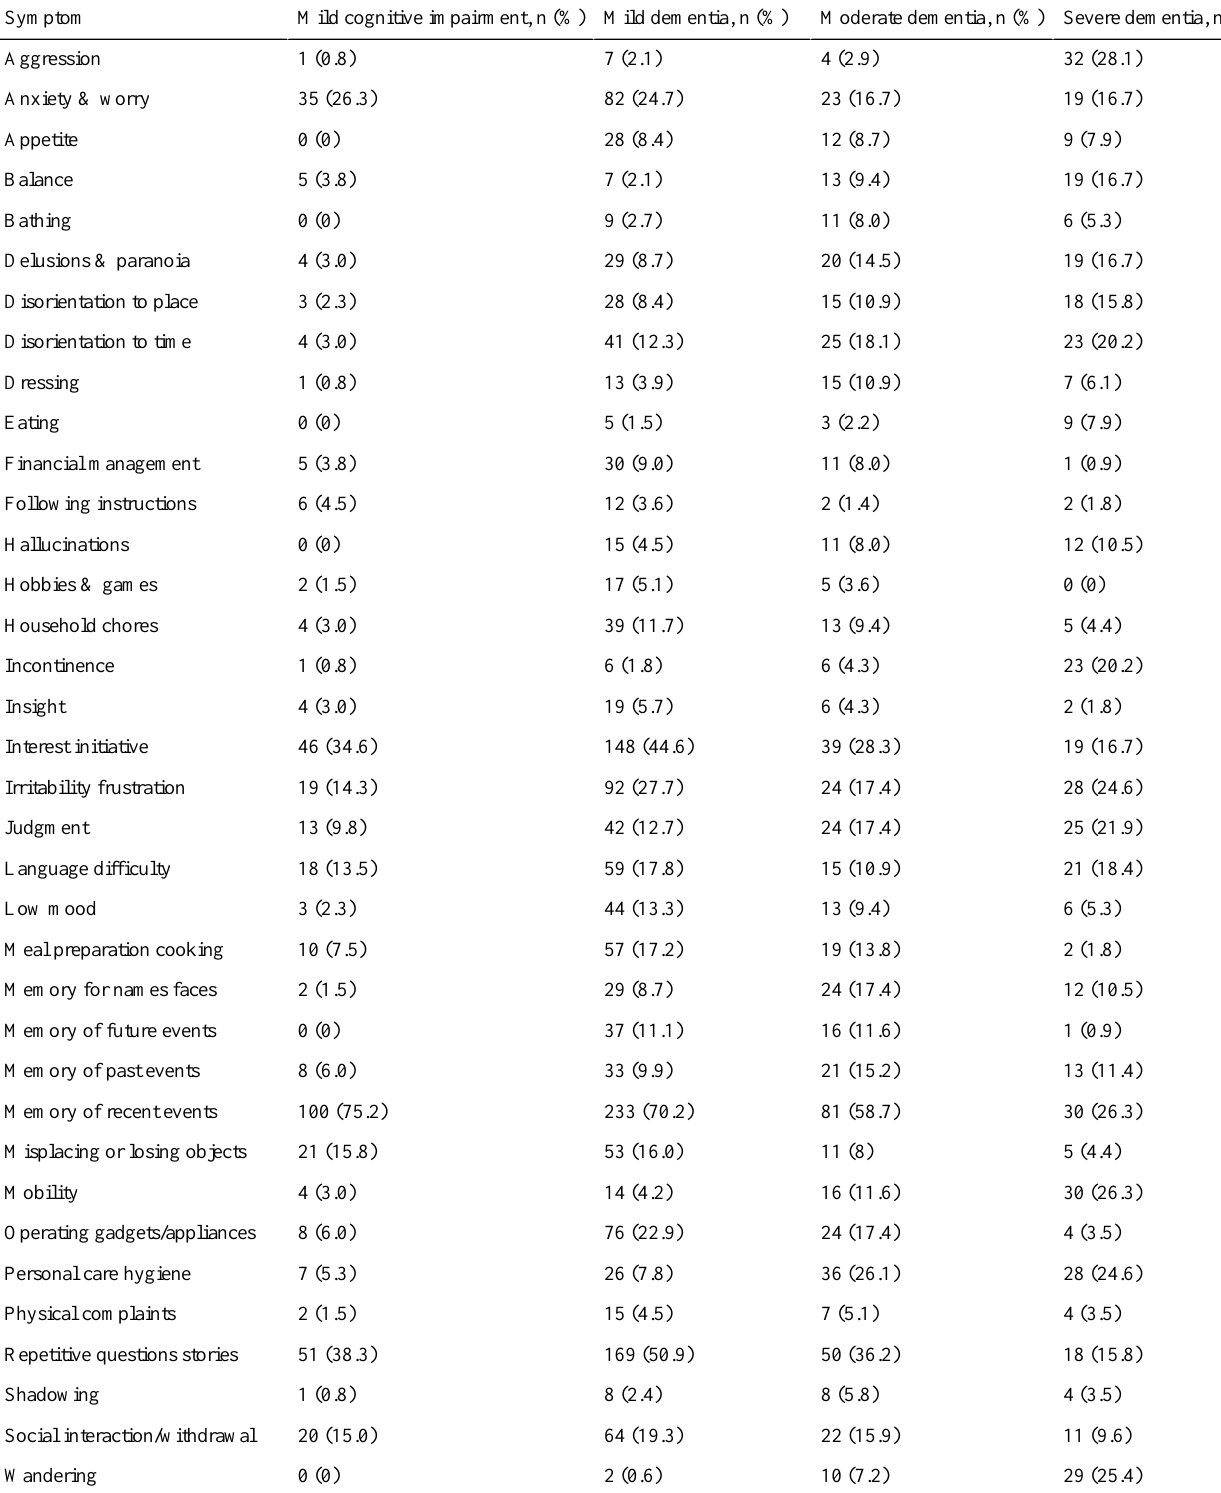
Table 2. Mean frequency of reported user profile symptoms of clinical study participants by clinically defined dementia stage.